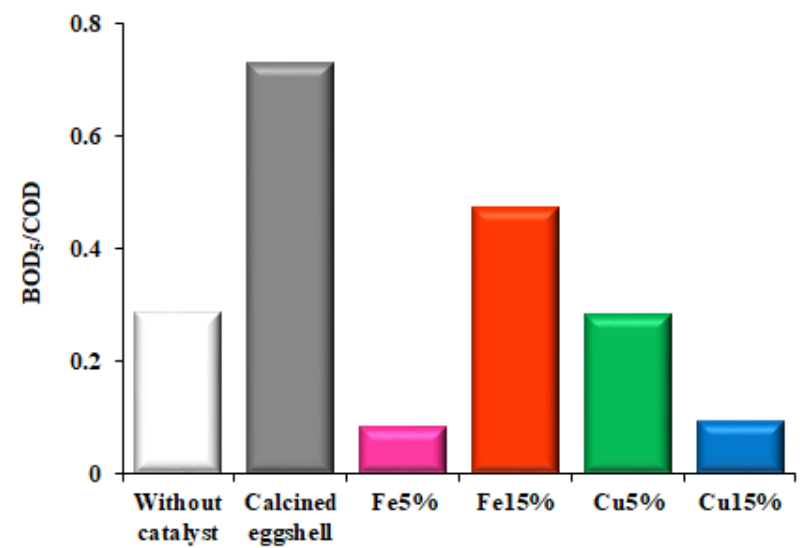
Figure 6. Biodegradability index values after 6 h of wet oxidation in absence of catalyst ( ), and in presence of the eggshell ( (cid:4) ) and the supported catalysts: Fe 5% ( (cid:4) ), Fe 15% ( (cid:4) ), Cu 5% ( (cid:4) ), and Cu 15% ( (cid:4) ). In all cases, T = 150 ◦ C, P = 40 bar, pH = 7.5, initial HA concentration = 400 ppm and catalyst concentration = 1 g/L.